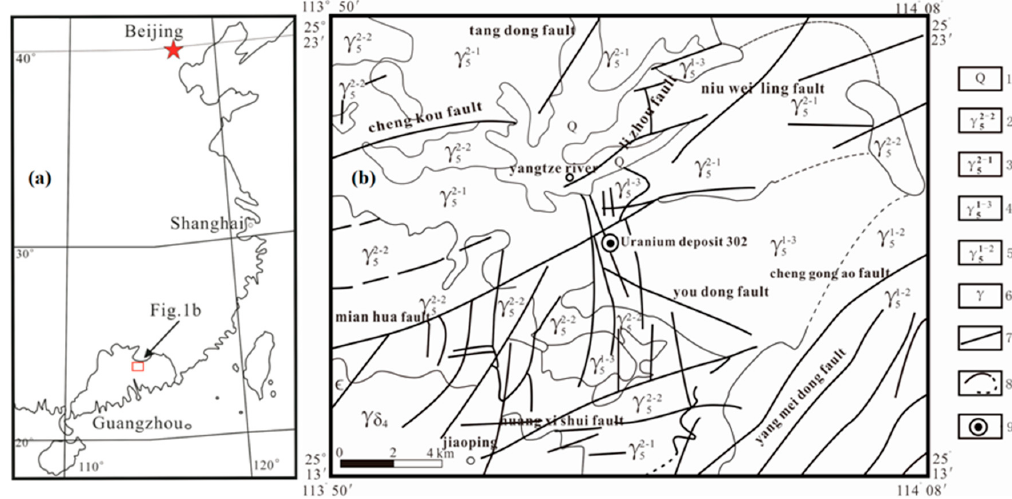
Figure 1. ( a ) Schematic map showing the location of the Mianhuakeng uranium deposit. ( b ) Geological sketch map of Mianhuakeng (No. 302) uranium deposit (after Huang et al. [30]). 1—Quartenary; 2—Medium-fine grained biotite-muscovite granite; 3—Medium-grained (porphyritic) biotite granite; 4—Medium-grained (porphymic) biotite-muscovite granite; 5—Medium-coarse grained porphyritic biotite monzonitic granite; 6—Granodiorite; 7—Fault; 8—Measured and inferred geological boundaries; 9—Uranium deposit.